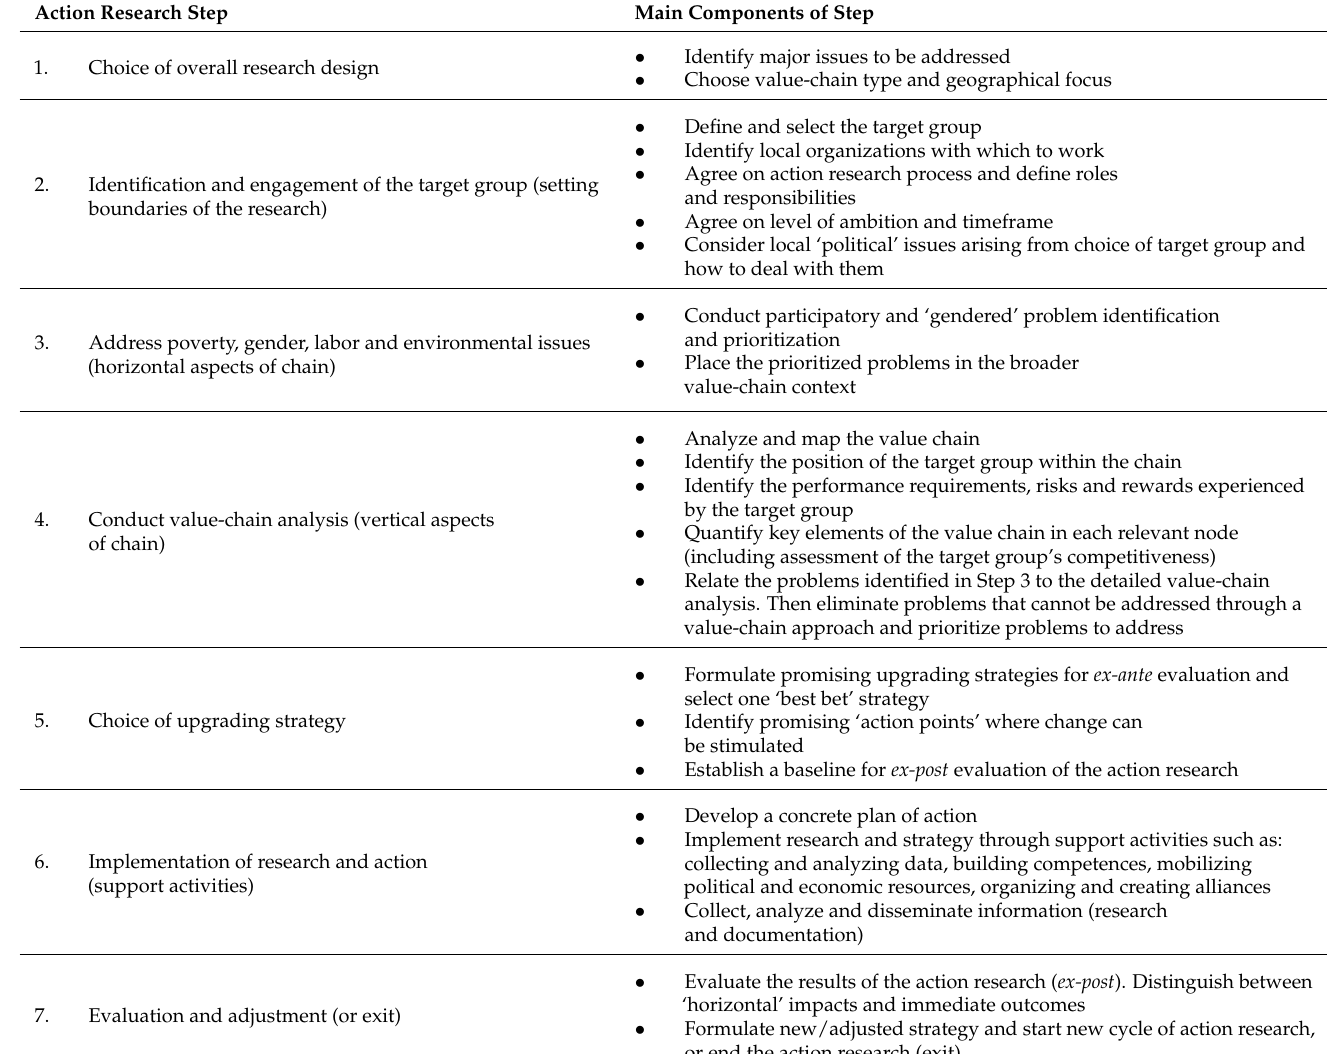
Table 1. The seven steps to design and implement research in value chains